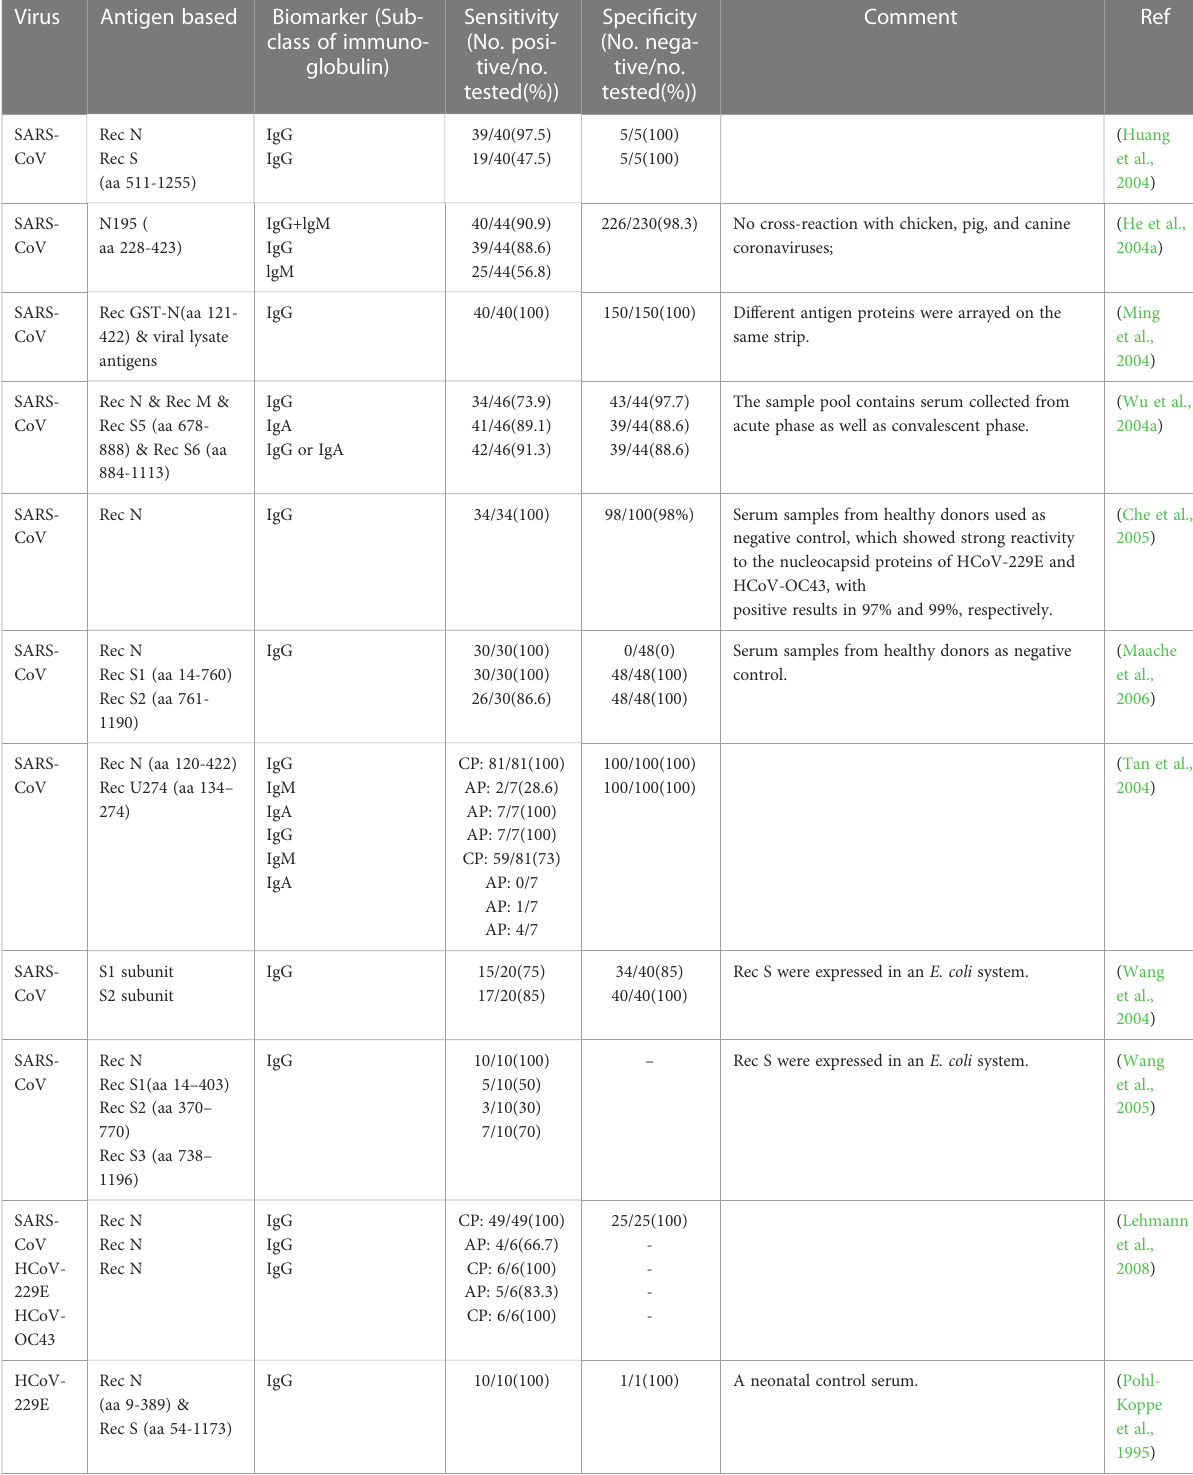
TABLE 4 WB for antibody detection validated by clinical